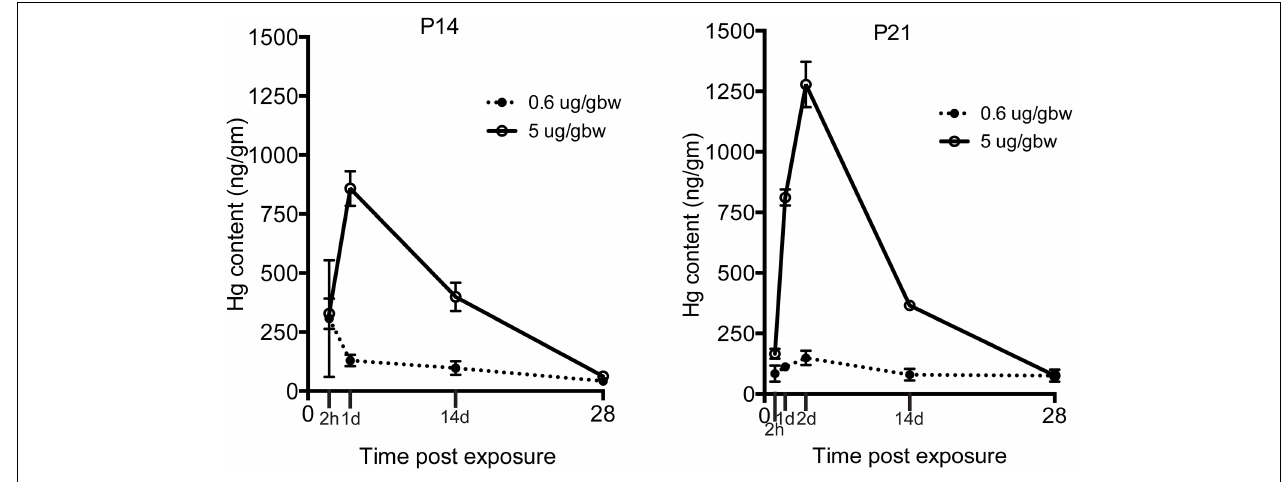
FIGURE 5 | Transfer of MeHg across the BBB does not diminish during the postnatal period. Hg concentrations are expressed in nanograms per gram (ng/gm) at time points from 2h to 4 weeks after two different exposures (0.6 or 5 µ g/MeHg) in two age groups (P14 and P21).